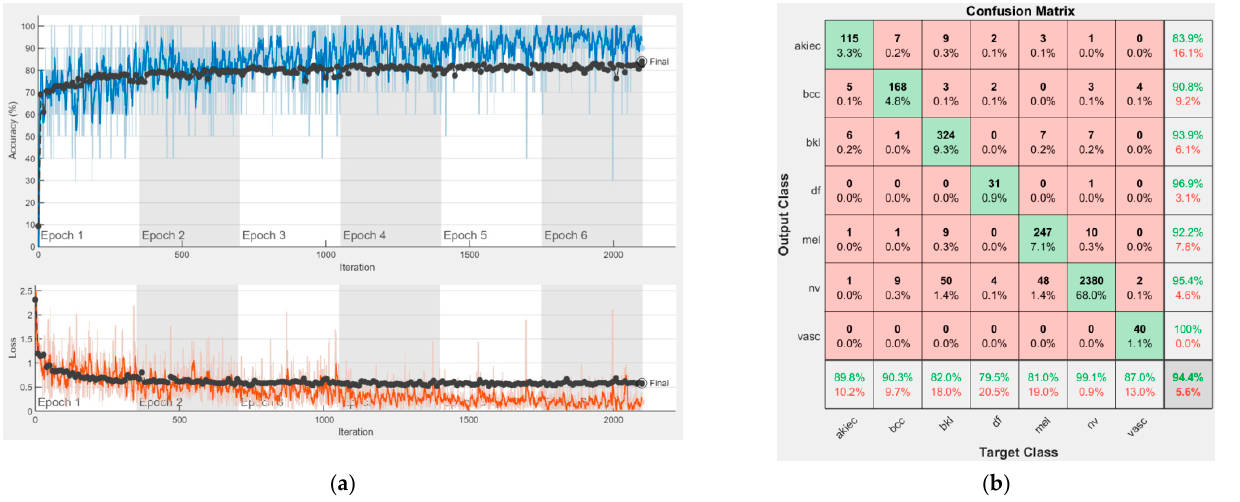
Figure 12. Results using ResNet-101, ( a ) Accuracy and loss, ( b ) Confusion matrix.